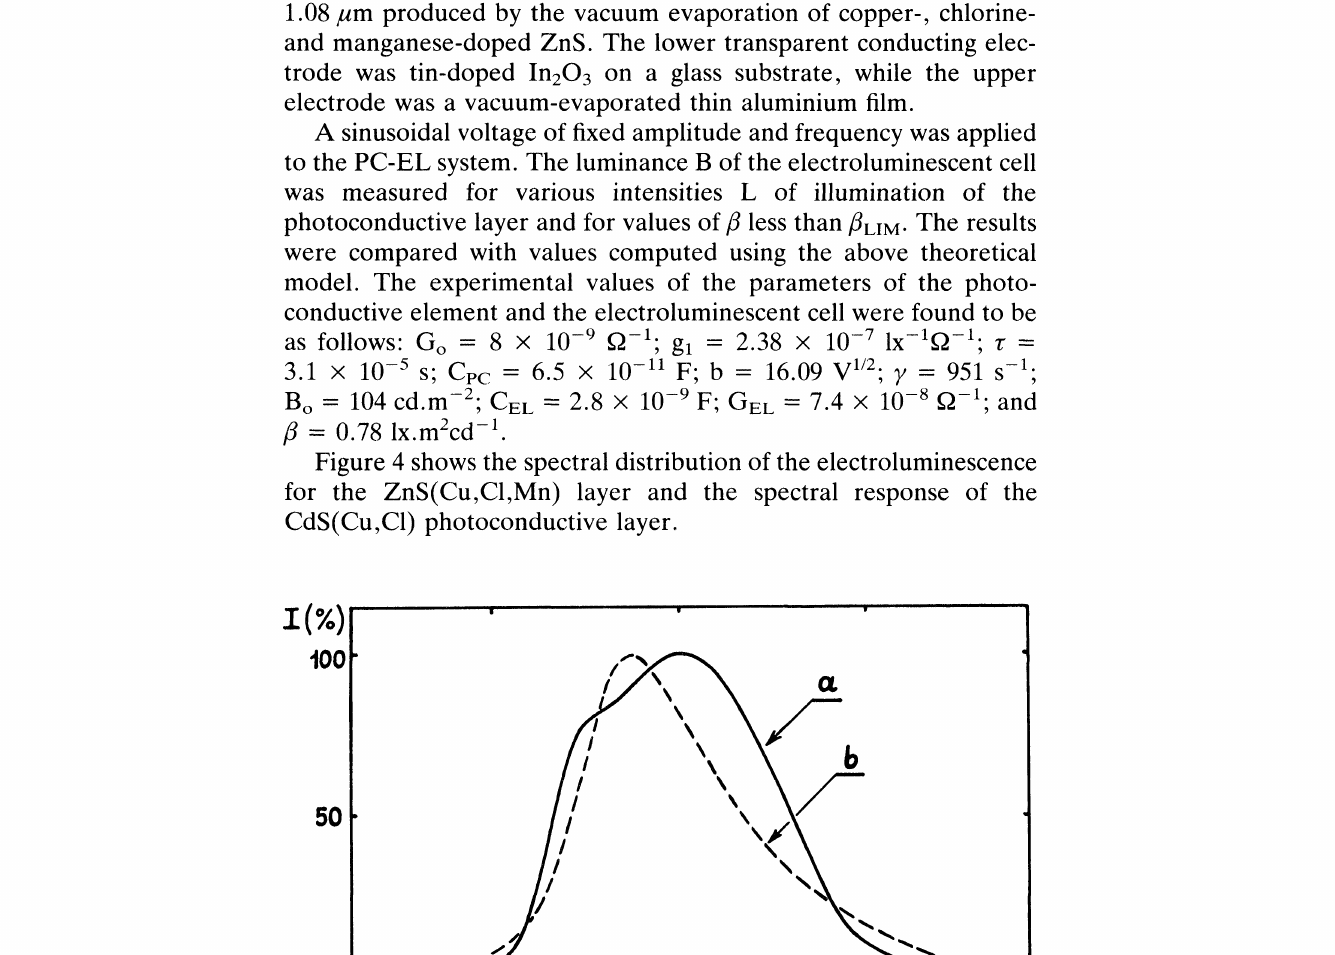
FIGURE 4 The spectral distribution I(%) vs. 2(nm) of the sensitivity of the CdS(Cu,CI) photoconductive layer (curve a) and of the electroluminescence of the ZnS(Cu,CI,Mn) layer (curve